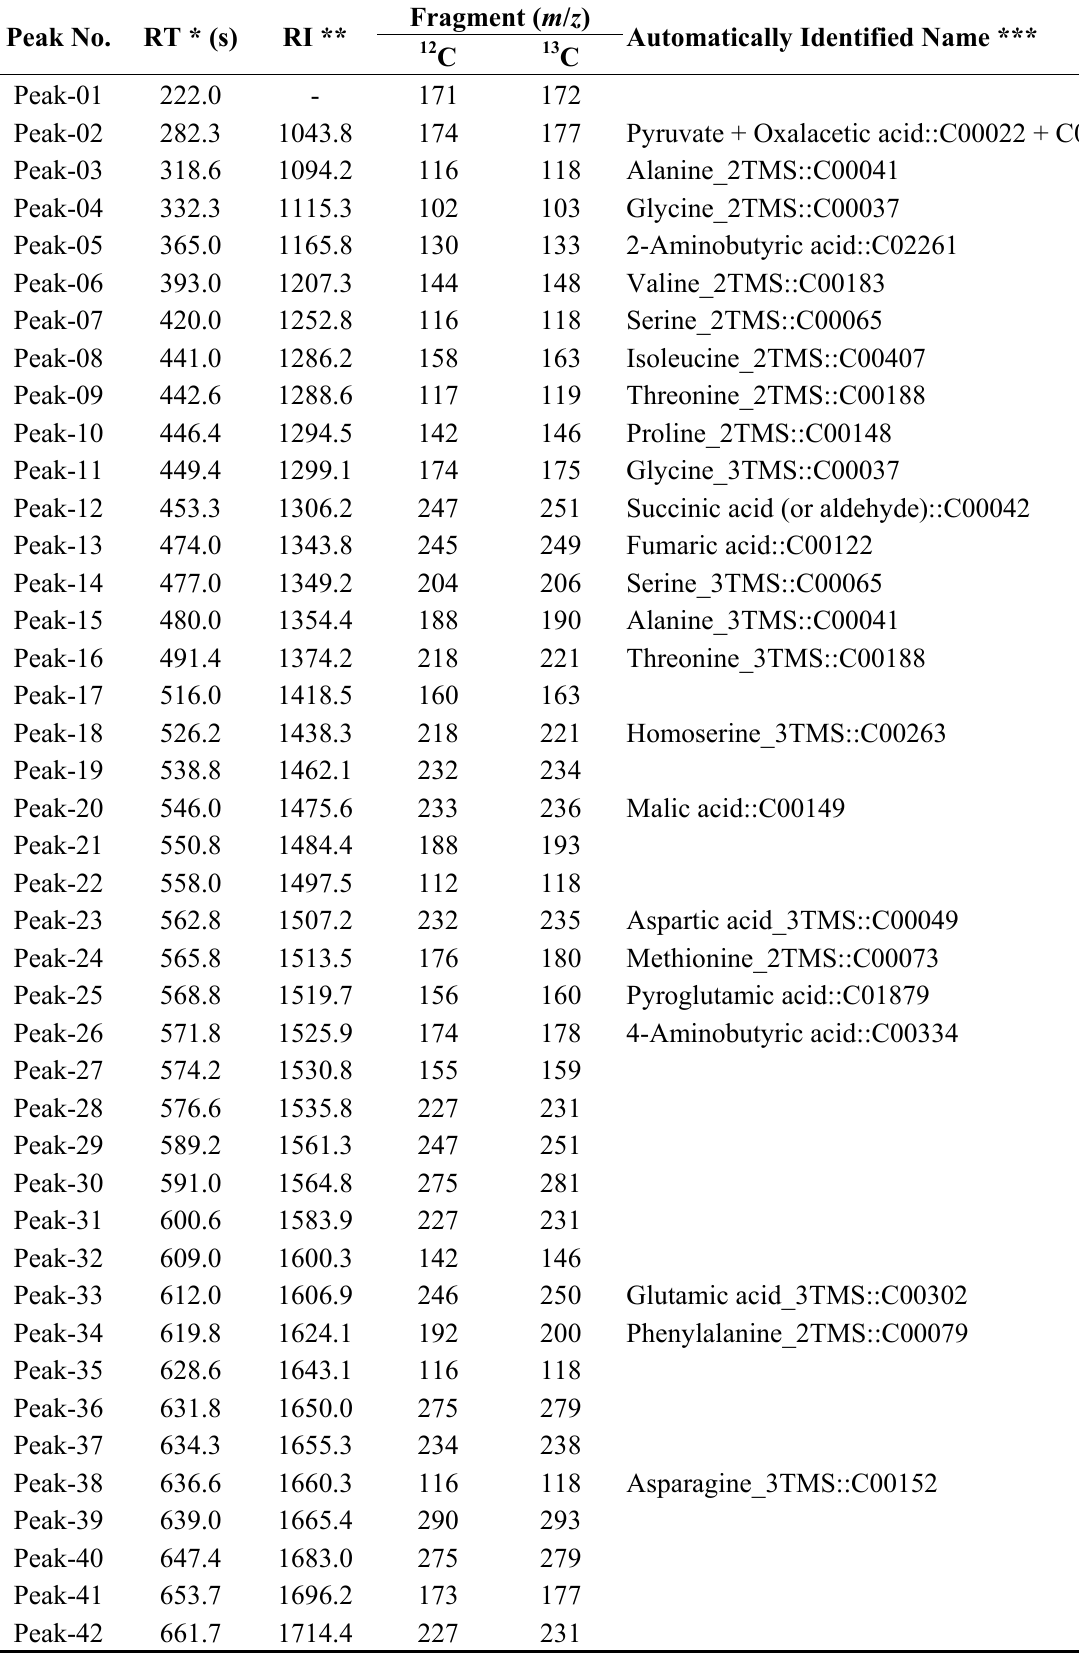
Table 1. Carbon-containing peaks derived from S. cerevisiae . Peak